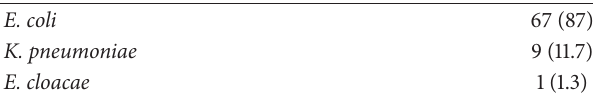
Table 2: Distribution of the bacterial isolates, 𝑛